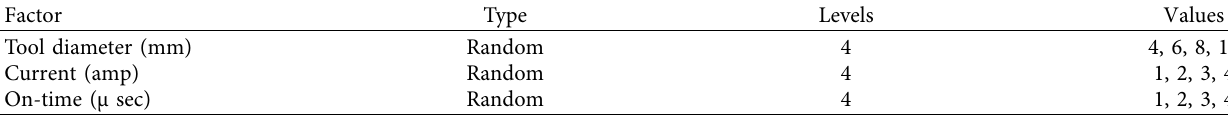
Table 4: General linear model: MRR versus tool diameter, current, and on-time.